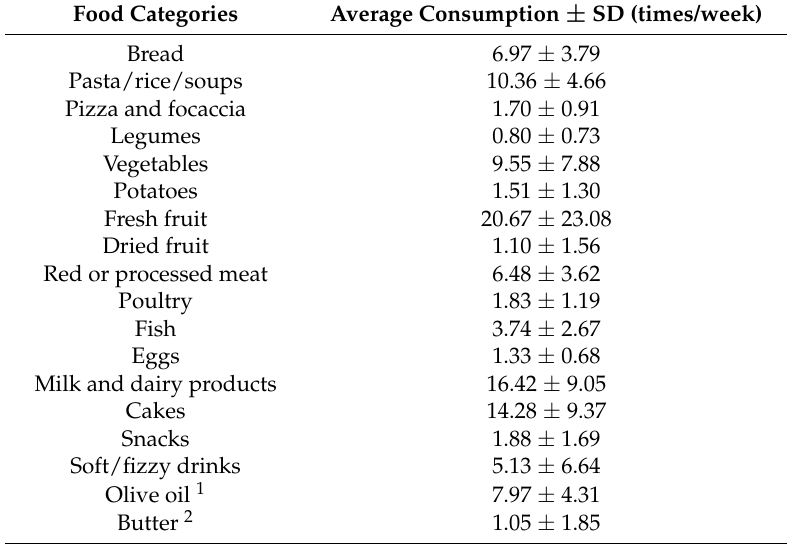
Table 2. Average weekly consumption of foods and beverages by the recruited